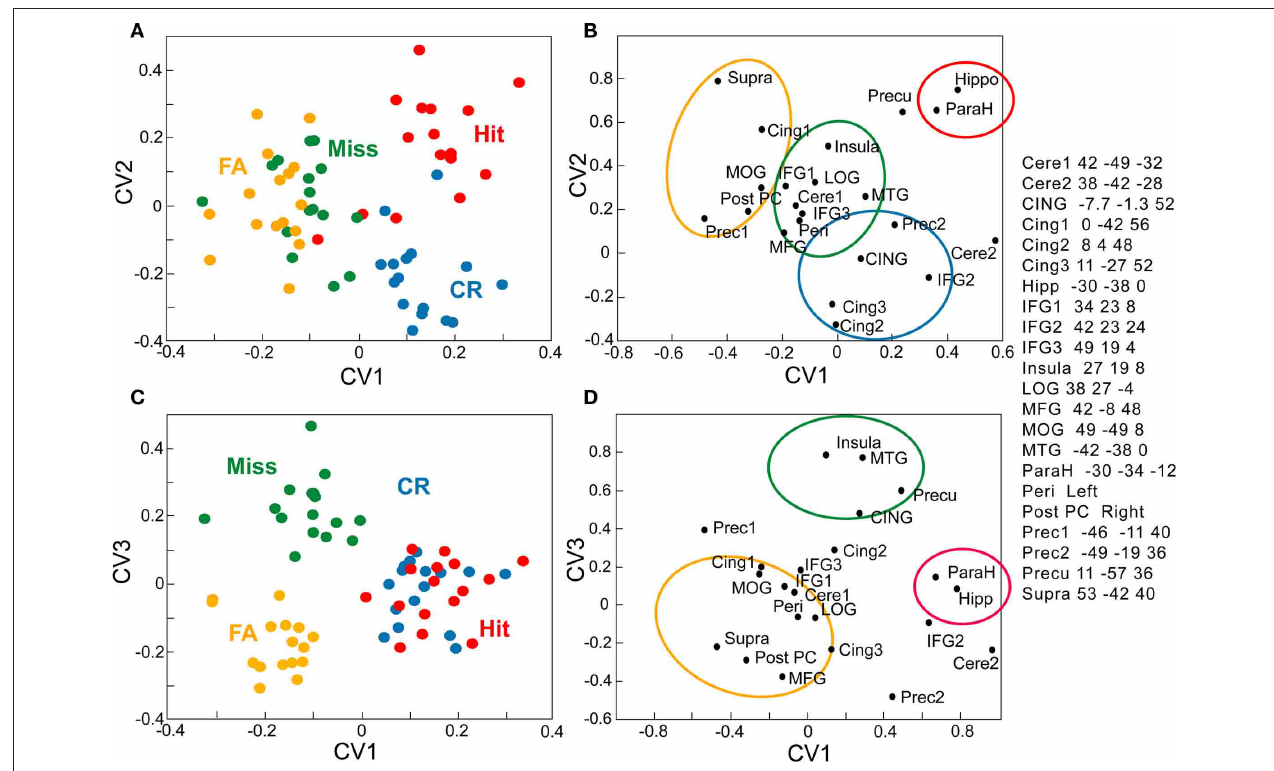
Cere, cerebellum; CING, mean of three ROIs in cingulate; Cing. cingulate; Hipp, hippocampus* IFG, inferior frontal gyrus, LOG, lateral occipital gyrus; MFG, middle frontal gyrus; MOG. middle occipital gyrus; MTG. middle temporal gyrus; ParaH, parahippocampal; reri, perihippocampal; Post PC; posterior piriform cortex; Prec, precentral; Precu, precuneus;